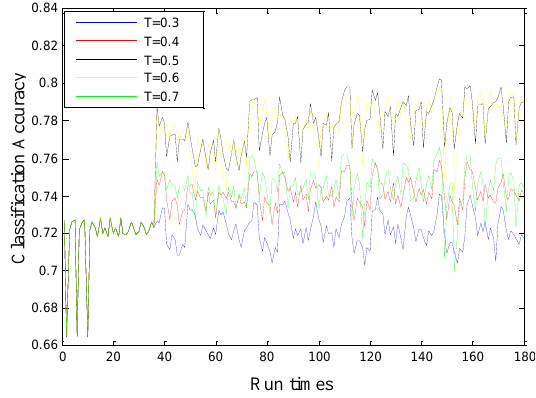
Figure 3 the impact of T for Classes 4 and 5 of KSC data